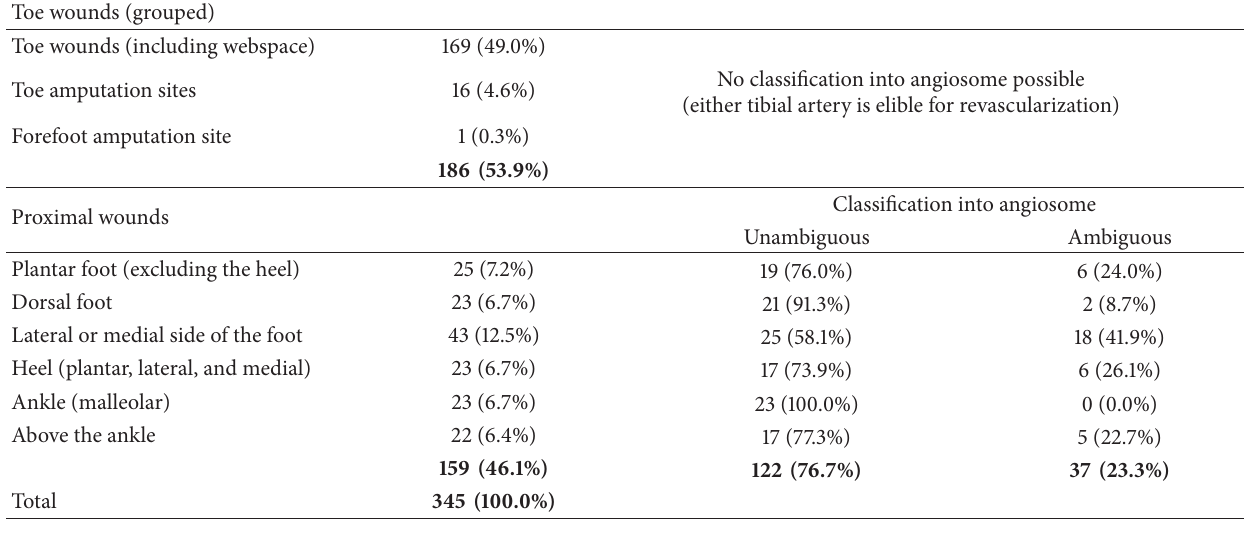
Table 2: Categorization of individual wounds into angiosomes ( 𝑛 = 345 ).